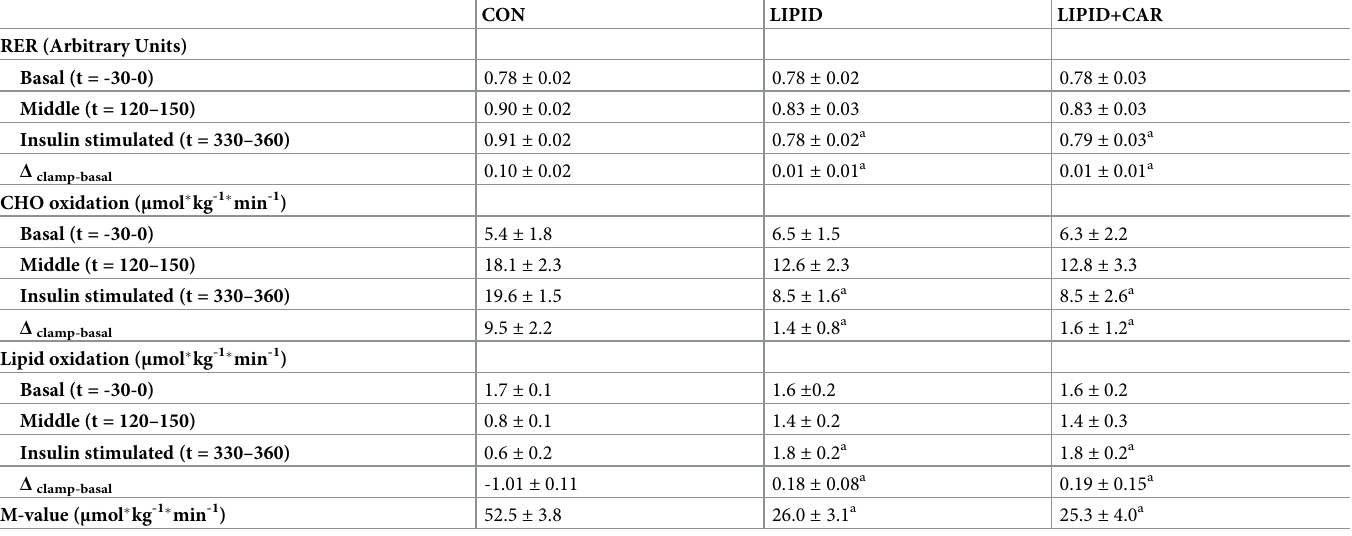
Table 2. Substrate kinetics and insulin sensitivity.